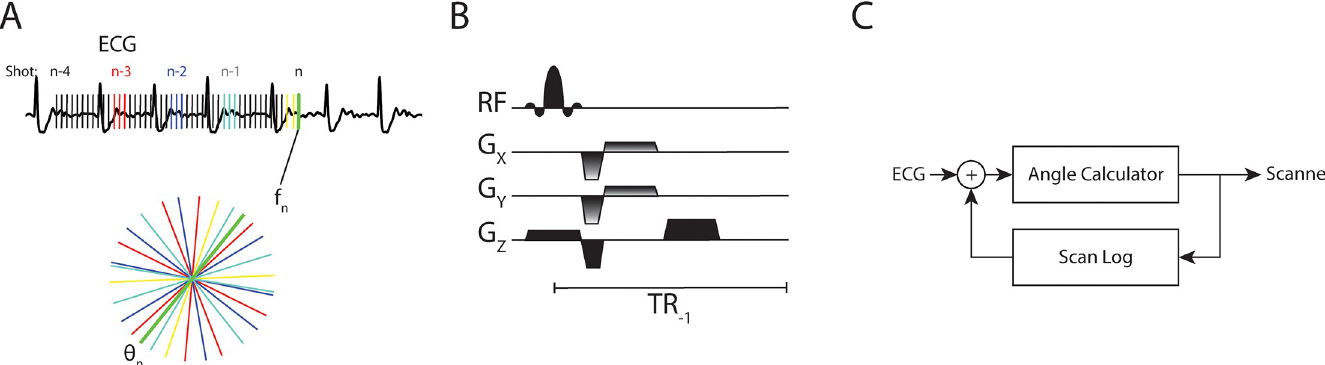
Fig 1. Segmented acquisition using an autonomous closed-loop system. A) During the acquisition, the closed-loop system identifies prior, similar phases of the cardiac cycle using cross-correlation of the recorded ECG signal. For frame f n , radial k-space lines from prior phases (red, blue, and teal) as well as the most recent views (yellow) are aggregated and the newest projection θ n (green) is defined to bisect the largest angle, thus closing the gap in k-space. B) The calculated angle θ n is provided to the bSSFP sequence in real-time such that the Gx and Gy gradients are updated. C) The closed loop nature of the physiologic signal (ECG), the angle calculator, scanner, and log of prior scan